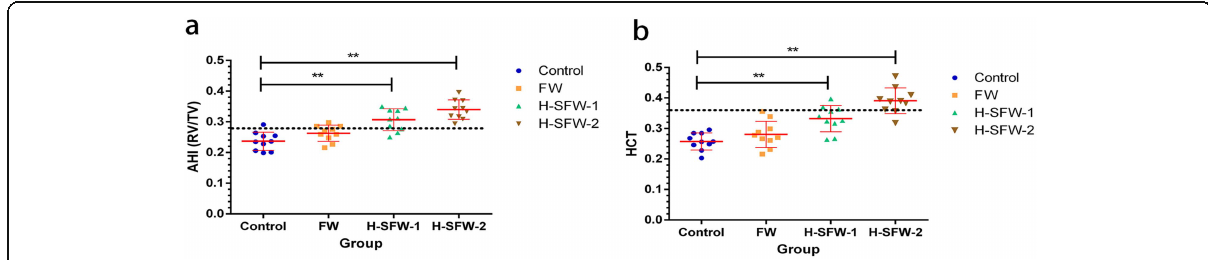
Fig. 1 Effects of different NaCl contents in drinking water on hematocrit (HCT) and ascites heart index (AHI) of broilers. They were randomly divided into four groups: a control group (deionized water, NaCl at 0g/L), a freshwater group (FW, deionized water + NaCl at 1g/L), high salinized freshwater group 1 (H-SFW-1, deionized water + NaCl at 2.5g/L) and high salinized freshwater group 2 (H-SFW-2, deionized water + NaCl at 5g/L). a AHI (RV/TV, right ventricular weight/total ventricular weight) of broilers in control group, FW group, H-SFW-1 group and H-SFW-2 group. ( n =10, ** P <0.01 vs. control). b HCT of broilers in control group, FW group, H-SFW-1 group and H-SFW-2 group ( n =10, ** P <0.01 vs.